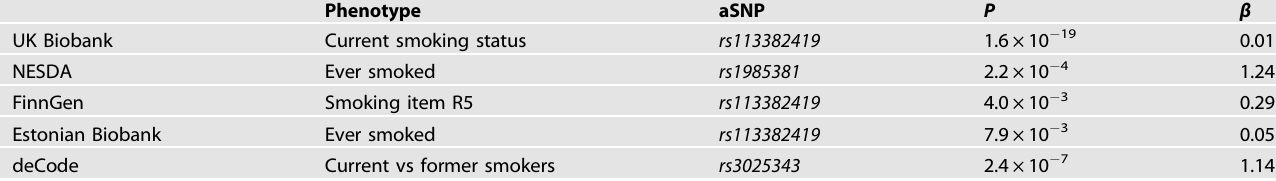
Table 1. GWAS summary statistics for Neandertal smoking risk allele.